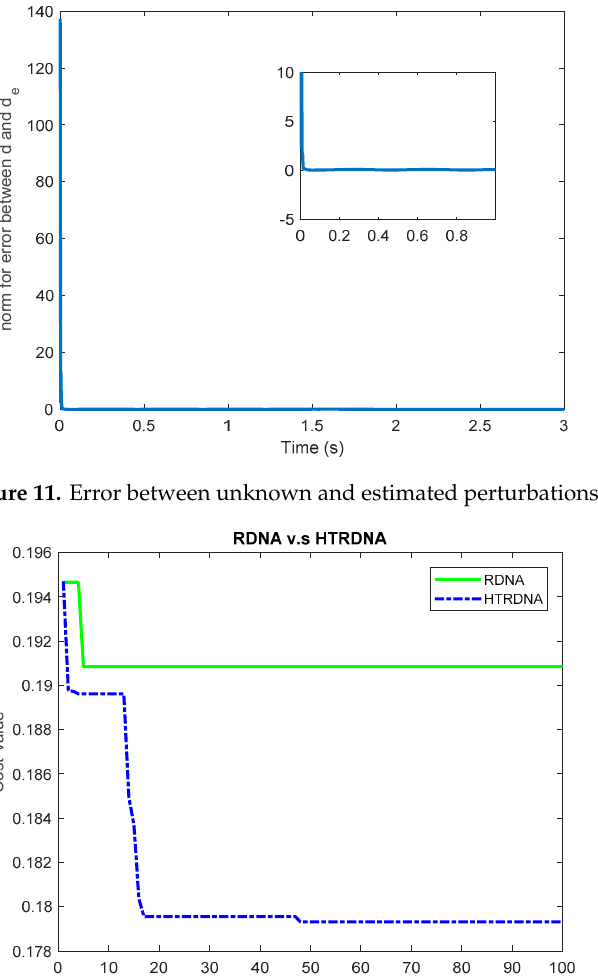
Figure 12. Evolution of RDNA and HTRDNA algorithm.